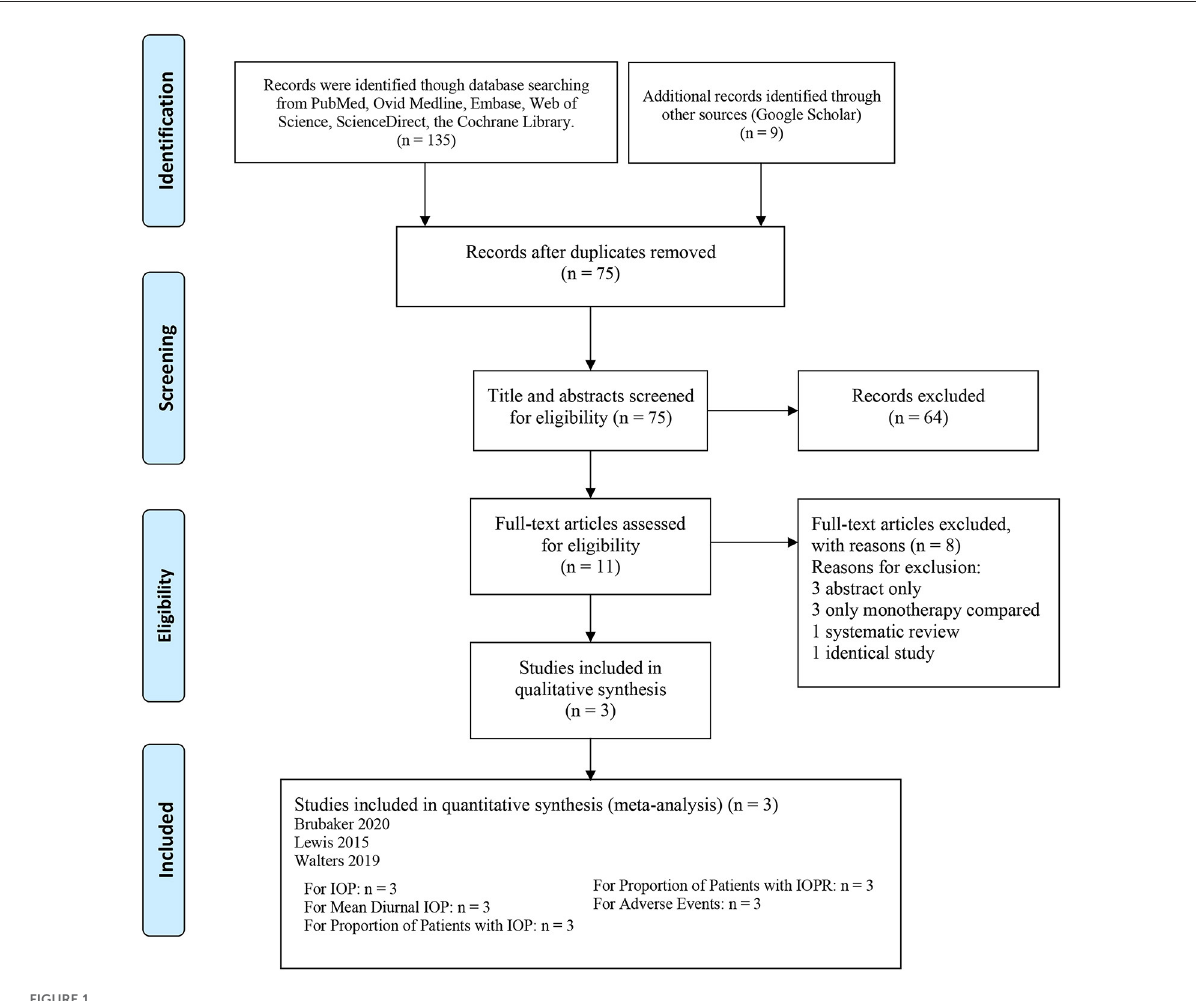
FIGURE1 Flow chart of study